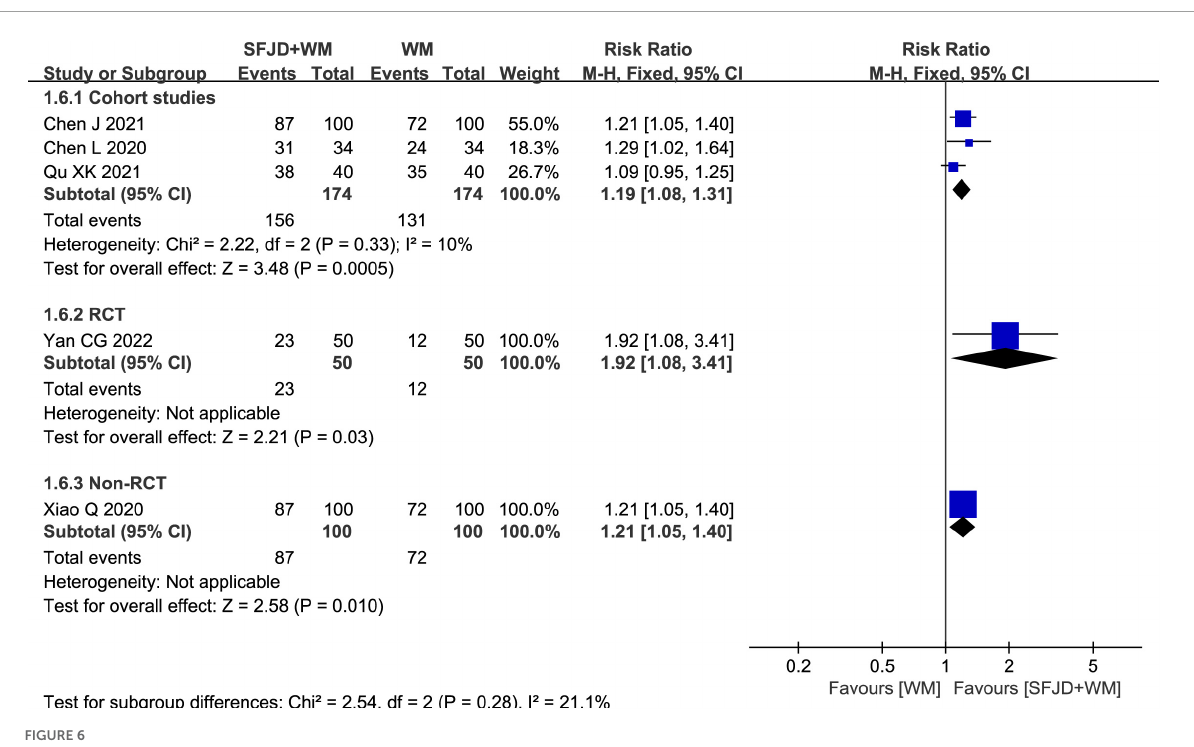
rhinorrhea ( MD = − 1.22 days, 95%CI: − 2.36 to − 0.07, P =